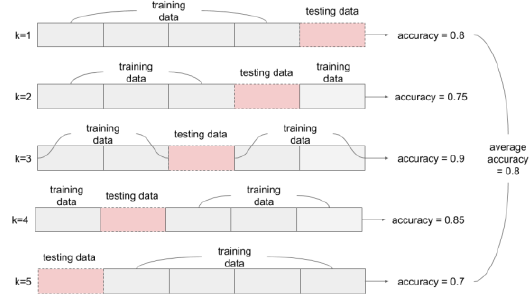
Figure 9. Concept of the K-fold cross-validation.